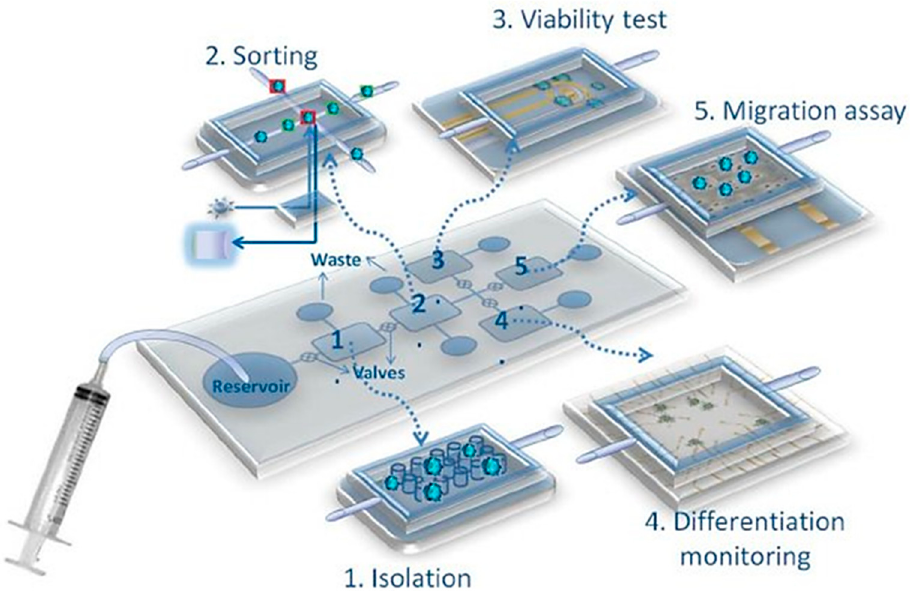
Figure 12. Example of a modular lab on a chip for stem cell studies. Several microfluidic components and sensing modules are integrated together for cell isolation, detection and counting, viability or migration assays, and differentiation studies. (Re-printed from Primiceri et al. [111]. Copyright (2013), with permission from The Royal Society of Chemistry).